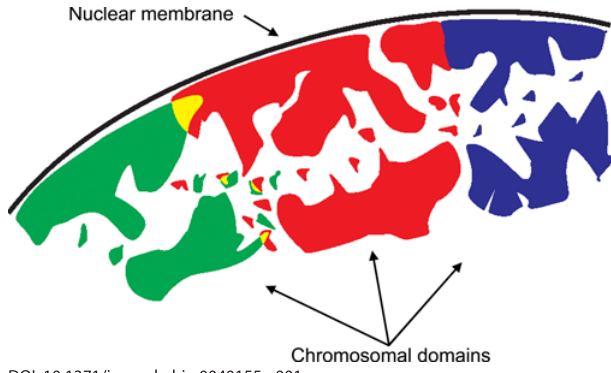
Figure 1. Schematic Illustration of Possible Neighborhood Organization Modes of Chromosomes A cross-section of part of the nucleus is shown, with the black line representing the nuclear membrane. The green, red, and blue areas indicate three different chromosomes. An interphase chromosome forms a three-dimensional meandering and invaginated territory of (partly) condensed chromatin from which decondensed chromatin fi bers extend. Two different modes of organization between neighboring chromosomes are indicated; one on the right between the red and blue chromosomes and the other on the left between the green and the red chromosomes. Domains from the red and blue chromosomes are either separated by interchromatin space or are in touch with no, or little, intermingling of chromatin. By contrast, domains from the green and red chromosomes overlap and their colocalization is indicated in yellow. This fi gure is based on